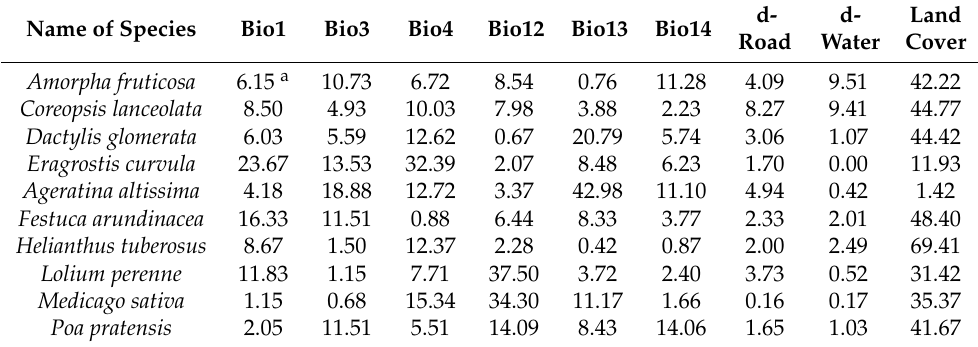
Table 2. Contribution of bioclimatic and environmental variables in the